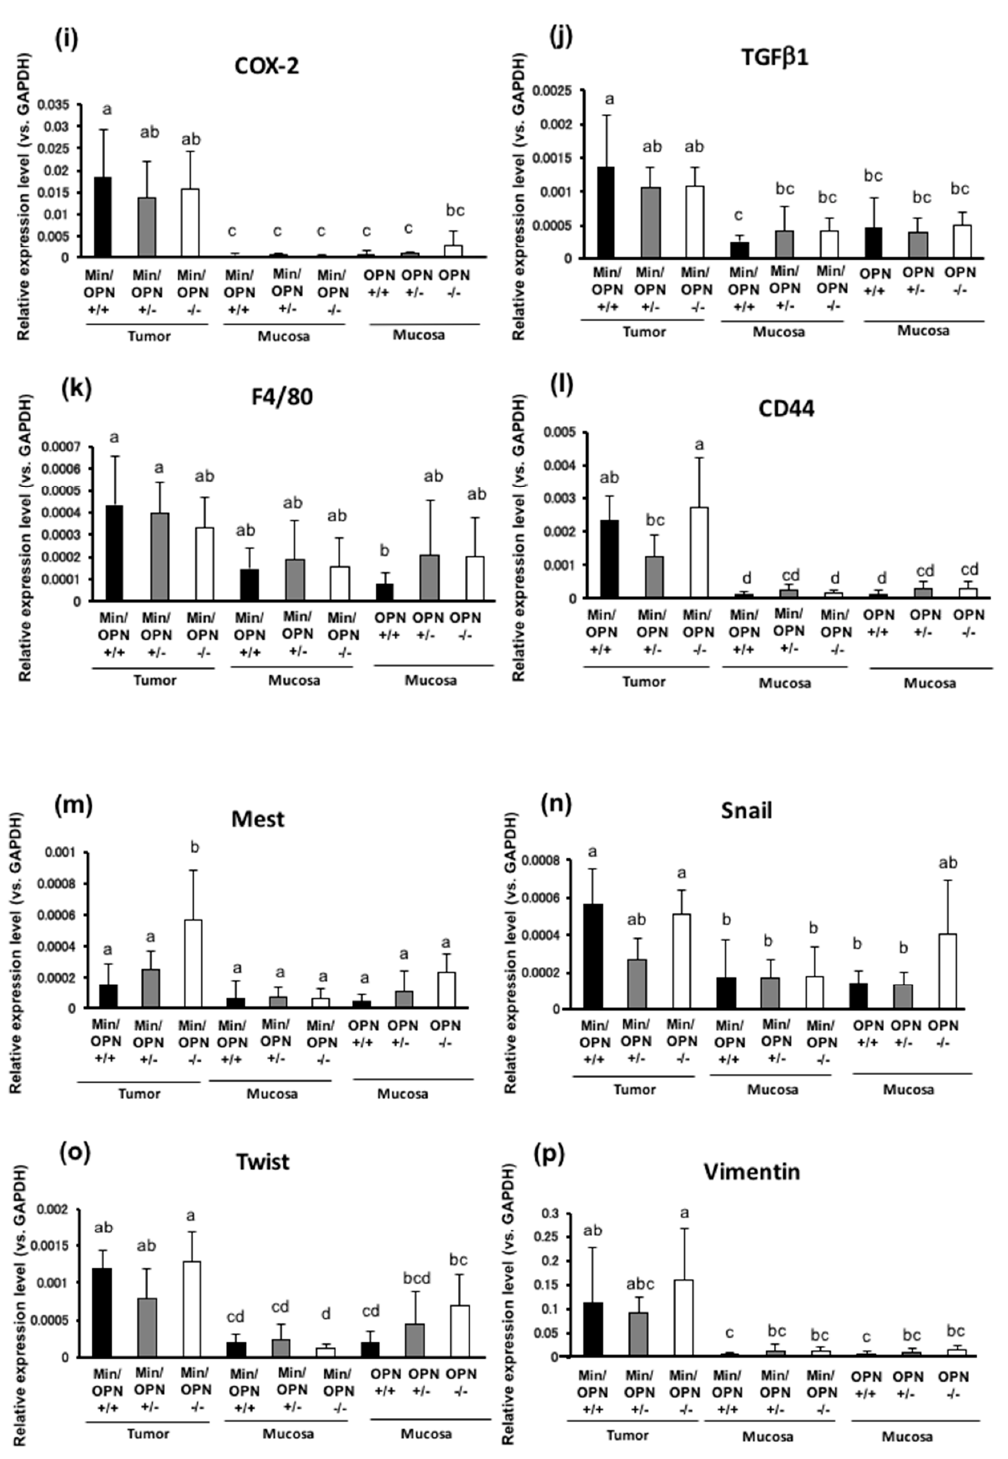
Figure 4. Effects of OPN deficiency on mRNA expression levels. Values for relative mRNA expression levels (vs. glyceraldehyde 3-phosphate dehydrogenase (GAPDH) of ( a ) OPN, ( b ) matrix metalloproteinase (MMP)-3, ( c ) MMP-9, ( d ) MMP-13, ( e ) MMP-2, ( f ) MMP-7, ( g ) Bcl-2, ( h ) CyclinD1, ( i ) COX-2, ( j ) transforming growth factor (TGF) β 1, ( k ) F4/80, ( l ) CD44, ( m ) Mest, ( n ) Snail, ( o ) Twist, and ( p ) Vimentin. Data are means ± SD. Values that do not share a common superscript are significantly different at p < 0.05.